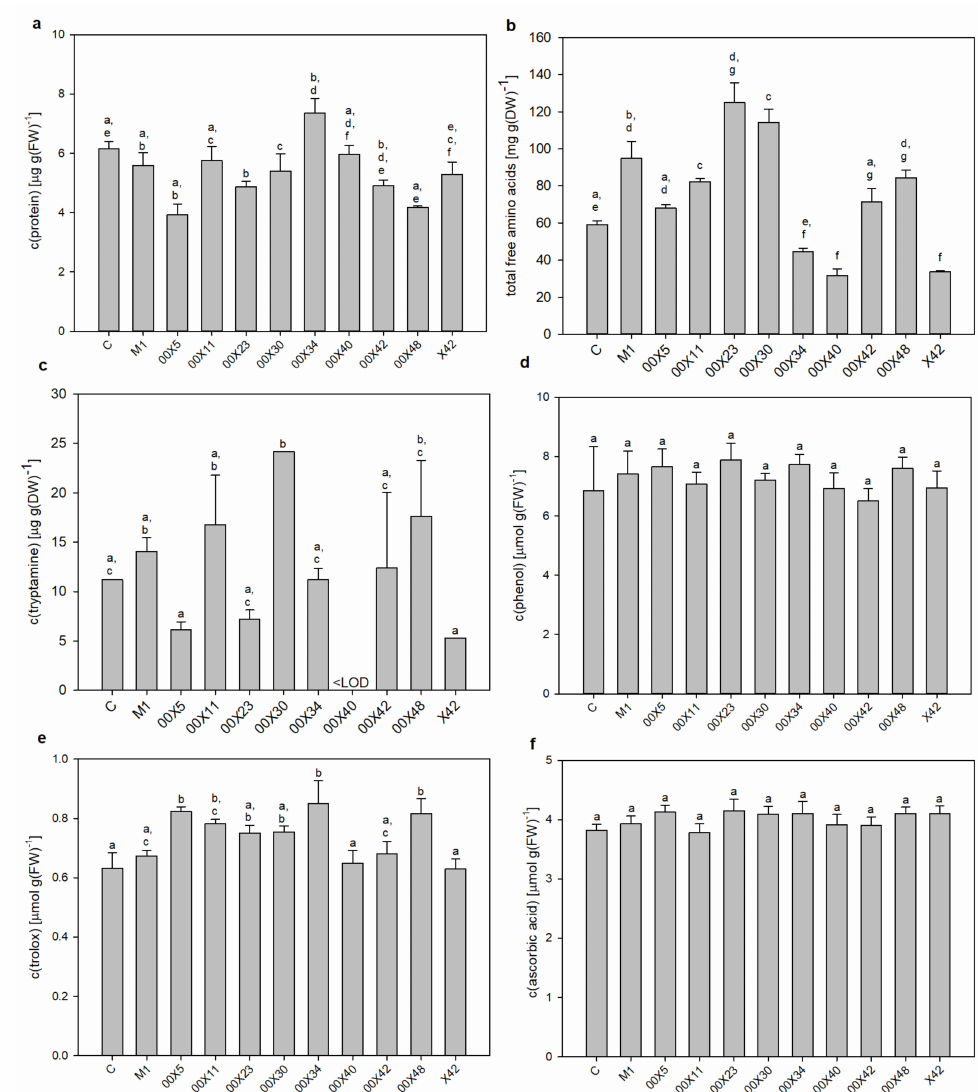
Figure 6. Characterization of the rapeseed leaves. Protein content ( a ), total free amino acids ( b ), tryptamine content ( c ), total phenolics ( d ), antioxidant capacity—2,2-diphenyl-1-picrylhydrazyl (DPPH) method ( e ), antioxidant capacity—Ferric Reducing Antioxidant Potential (FRAP) method ( f ). Each code (00X5, 00X11, 00X23, 00X30, 00X34, 00X40, 00X42, 00X48, X42, and M1) represents rapeseed